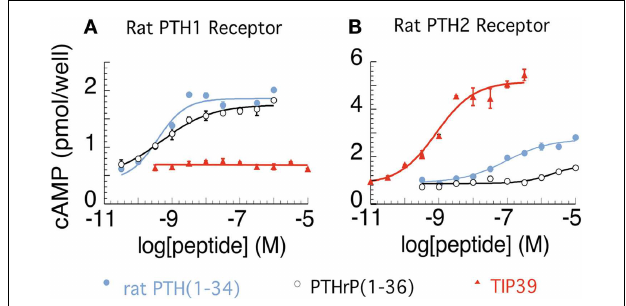
FIGURE 1 |Activation of rat parathyroid hormone 1 (PTH1) and PTH2 receptors. cAMP accumulation is shown in relation to increasing concentrations of PTH, PTH-related peptide, and tuberoinfundibular peptide of 39 residues (TIP39) in COS7 cells expressing the rat PTH1R (A) and the rat PTH2R (B) , respectively.The figure was created from data presented previously (Hoare and Usdin, 1999; Hoare et al., 1999a; Usdin et al.,